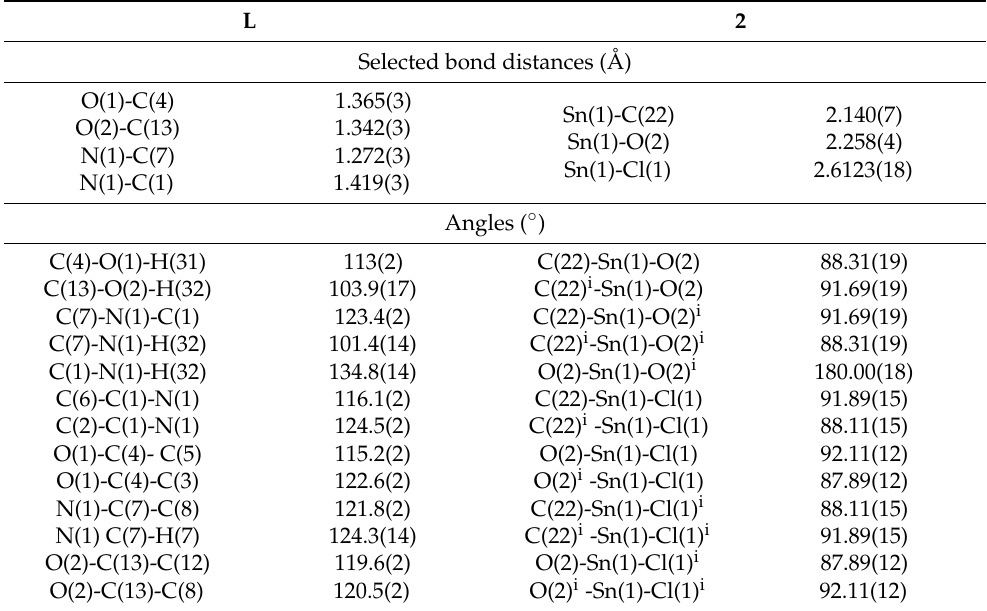
Table 2. Selected bond distances (Å) and angles ( ◦ ) for compounds L and 2 . Symmetry operation i = − x, 1 − y, 1 − z. L 2